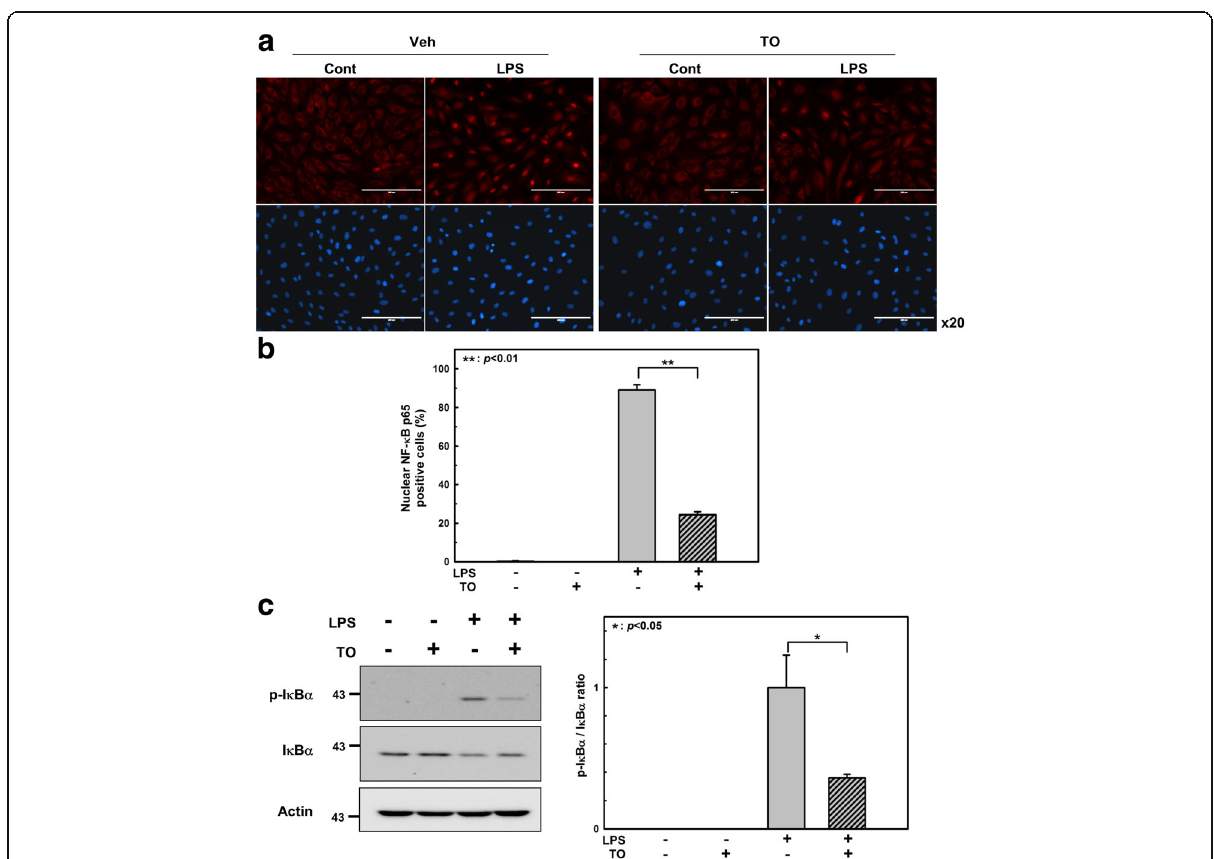
Fig. 5 Effect of the Taraxacum officinale (TO) methanol extract on the LPS-induced nuclear translocation of NF- κ B p65 in HUVECs. HUVECs were pretreated with TO extract (100 μ g/ml) for 1 h and then stimulated with LPS (1 μ g/ml) for 1 h. a Representative images of immunofluorescence staining showing NF- κ B p65 (red) and cell nuclei stained with Hoechst 33,258 (blue). Scale bars: 200 μ m. b Quantitation of NF- κ B p65 nuclear translocation in the indicated groups. c I κ B α phosphorylation assessed by western blot analysis. Results are shown as the mean±SE ( n =3 – 4). * p <0.05, ** p <0.01 vs LPS only treatment